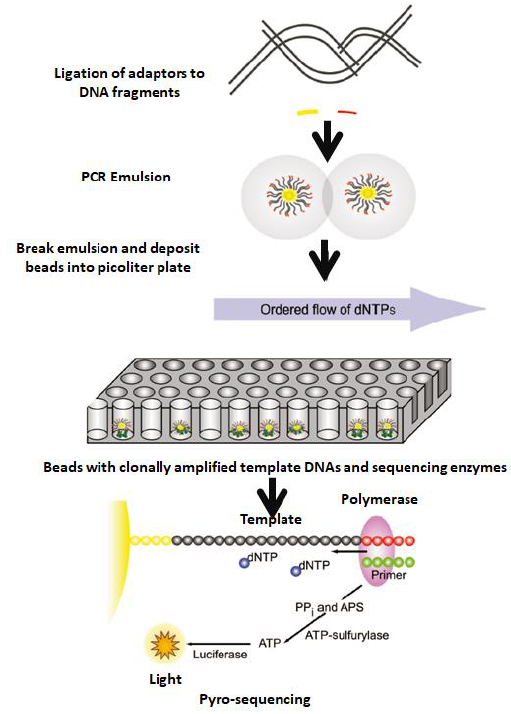
Figure 2. Template DNA is fragmented, end-repaired, ligated to adapters, and clonally amplified by emulsion PCR. After amplification, the beads are deposited into picotiter-plate wells with sequencing enzymes. The picotiter plate functions as a flow cell where iterative pyrosequencing is performed. A nucleotide-incorporation event results in pyrophosphate (PPi) release and well-localized luminescence. APS, adenosine 5-phosphosulfate. Reprinted with permission from ref. [15]. Copyright 2009, Oxford University Press.